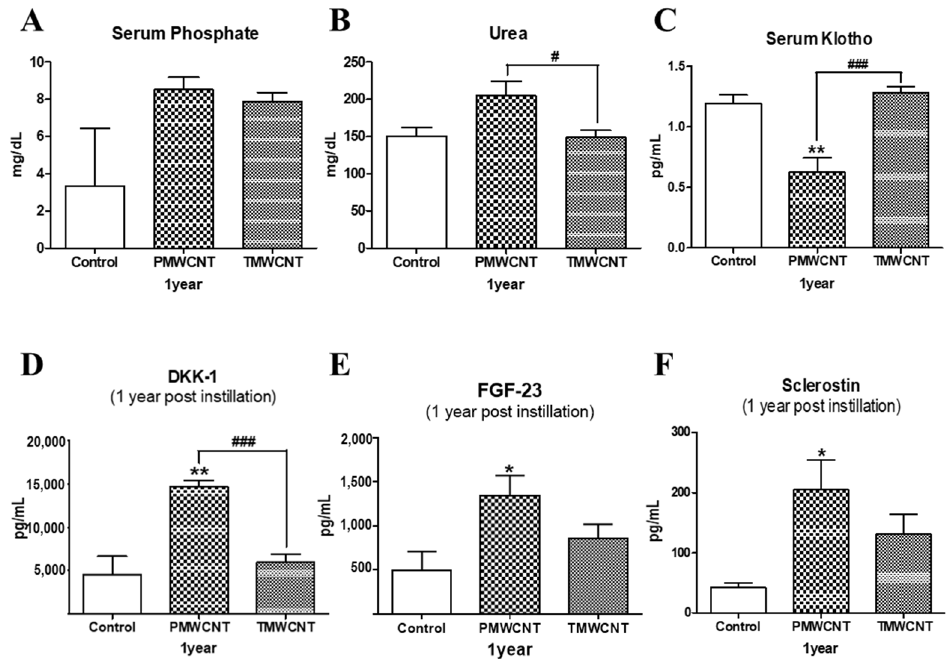
Figure 7. Serum analysis of mice after 1 year of instillation. ( A ) Serum phosphate, ( B ) Blood urea nitrogen, ( C ) Serum Klotho, ( D ) Serum DKK-1, ( E ) Serum FGF-23 and ( F ) Serum sclerostin levels after 1 year of treatment with saline, PMWCNTs, and TMWCNTs. Each bar represents the mean ± S.E.M. (n = 5). * Statistically different ( p < 0.05) compared to the control group. ** Statistically different ( p < 0.01) compared to the control group. # Statistical difference ( p < 0.05) between the two indicated groups. ### Statistically di ff erent ( p < 0.001) between the two indicated groups.